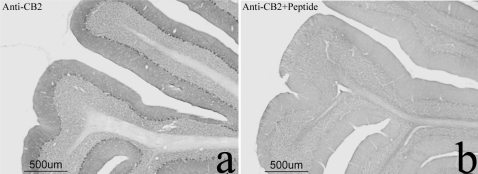
Brain CB2-Rs: Immunoractivity (IR) and pre-adsorption with immunizing peptide.
A, CB2-IR in the left panel and lack of CB2-IR in the right panel, B, when the CB2 antibody was pre-adsorped with the peptide.